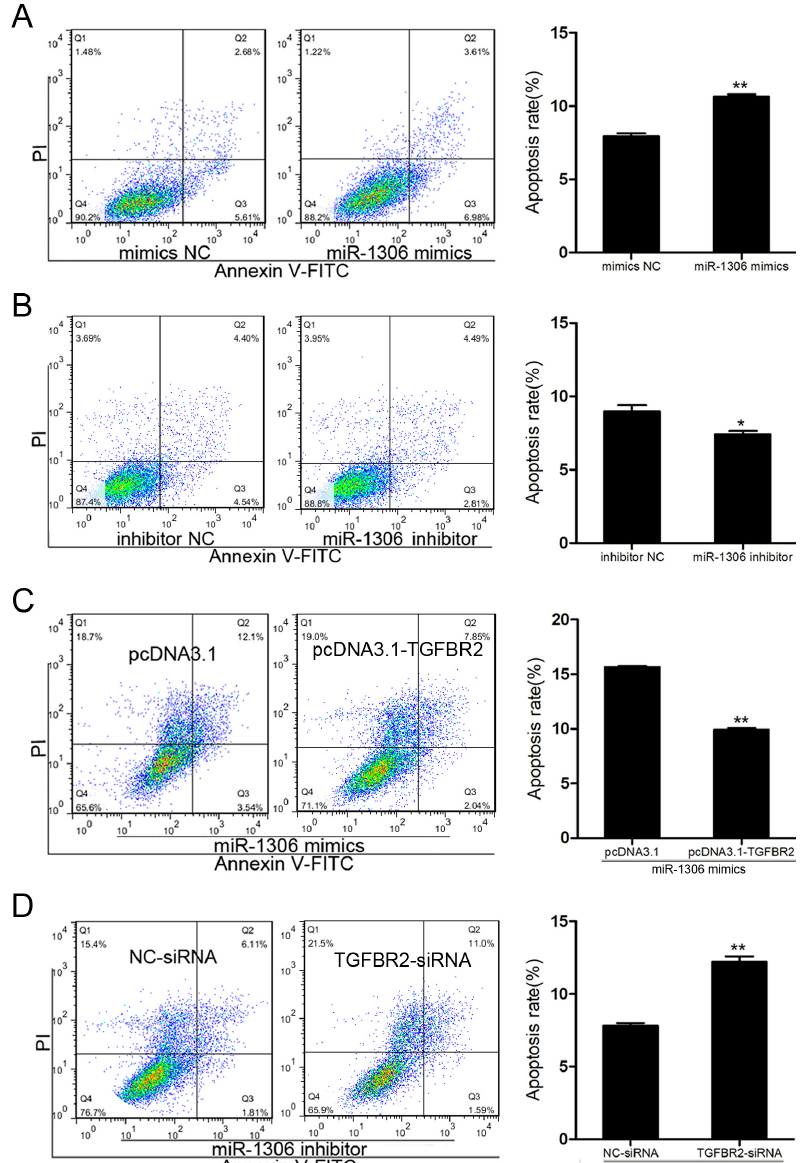
Figure 3. miR-1306 acts as an apoptotic factor in porcine GC through targeting TGFBR2. ( A , B ) Results showing the levels of GC apoptosis was ( A ) increased when cells were treated with mimic and ( B ) inhibited when cells were treated with miR-1306 inhibitor. The apoptotic cells were measured by fluorescence-activated cell sorting （ FACS ） (left panel) and the positive rates were calculated (right panels). ( C, D ) miR-1306 regulates GC apoptosis by inhibiting TGFBR2. ( C ) miR-1306 and TGFBR2 were both overexpressed or ( D ) silenced in porcine GCs. The apoptotic cells were identified by FACS (left panels) and the positive rates were calculated (right panel). Each experiment has three independent repetition and results are shown as mean ± SEM. * indicates p <0.05; ** indicates p <0.01. 3.5. Transcription Factor SMAD4 Regulates miR-1306 Transcriptional Activity, but Does Not Depend on its Host Gene DGCR8